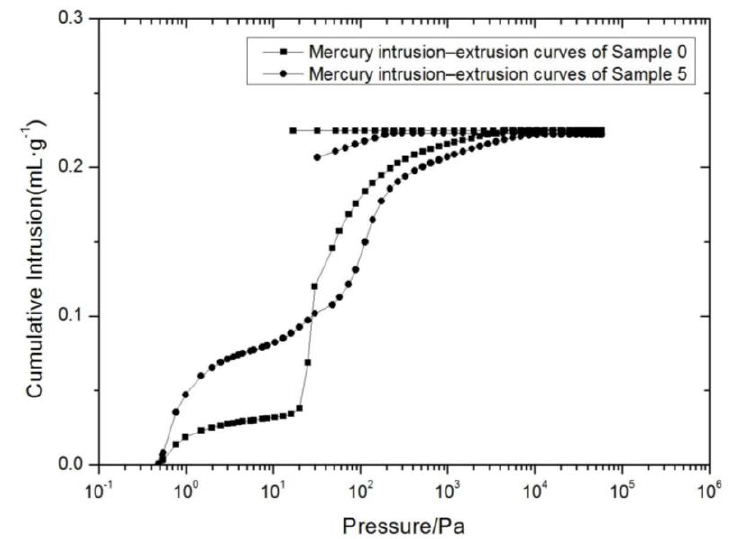
Figure 7. Mercury intrusion-extrusion curve.